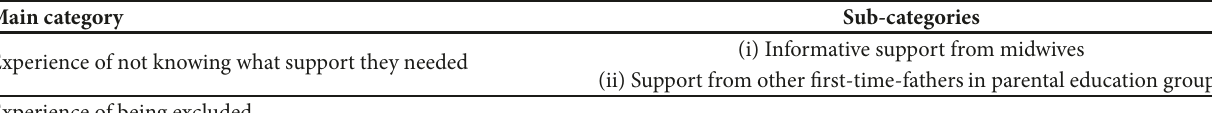
Table 2: Overview of findings from the open questions: the inductive